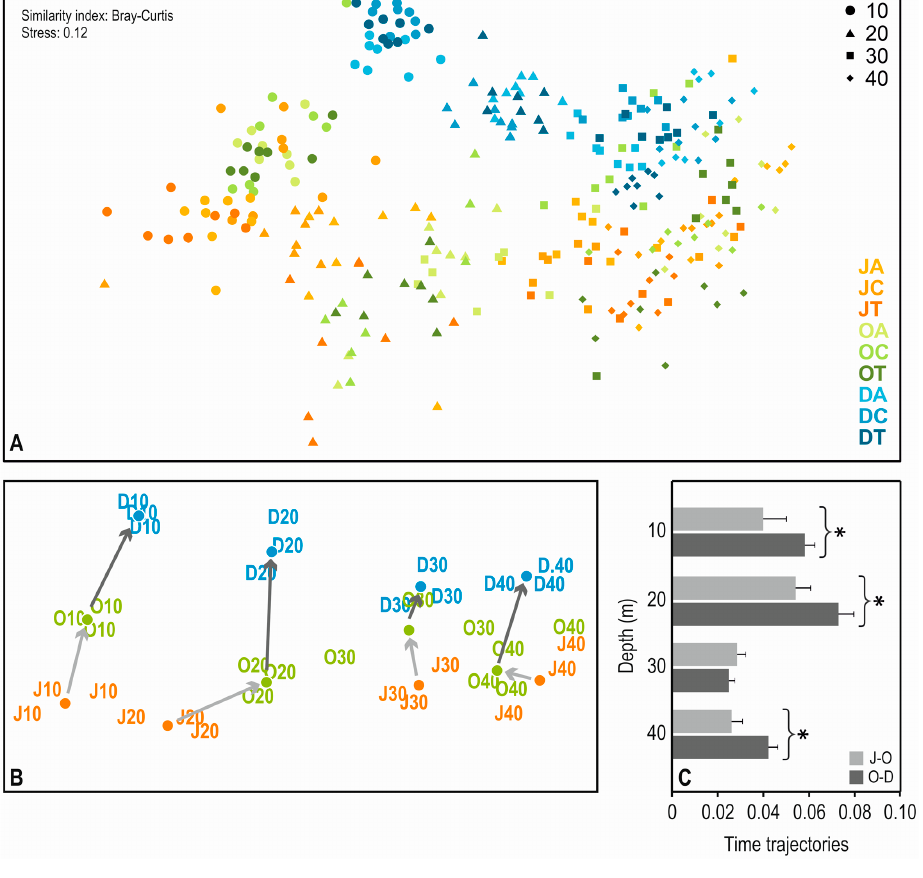
Figure 4. ( A ) Multivariate analysis (nMDS) plot of Portofino MPA species/OTU ratios. Individual observation points are represented by different colours and shapes according to time (J = June, shown in orange; O = October, shown in green; D = December, shown in blue) and depth. The colour gradations represent different sites at the three times (A = Altare; C = Colombara; T = Torretta). ( B ) The nMDS plot showing only the centroids and with time trajectories represented by arrows (light grey for trajectories between June and October; dark grey for trajectories between October and December). ( C ) Differences (* = significance p < 0.001) between time trajectory values (derived from axis scores and analysed with Student’s t -test) for June to October and October to December at each depth (10 m, 20 m, 30 m, and 40